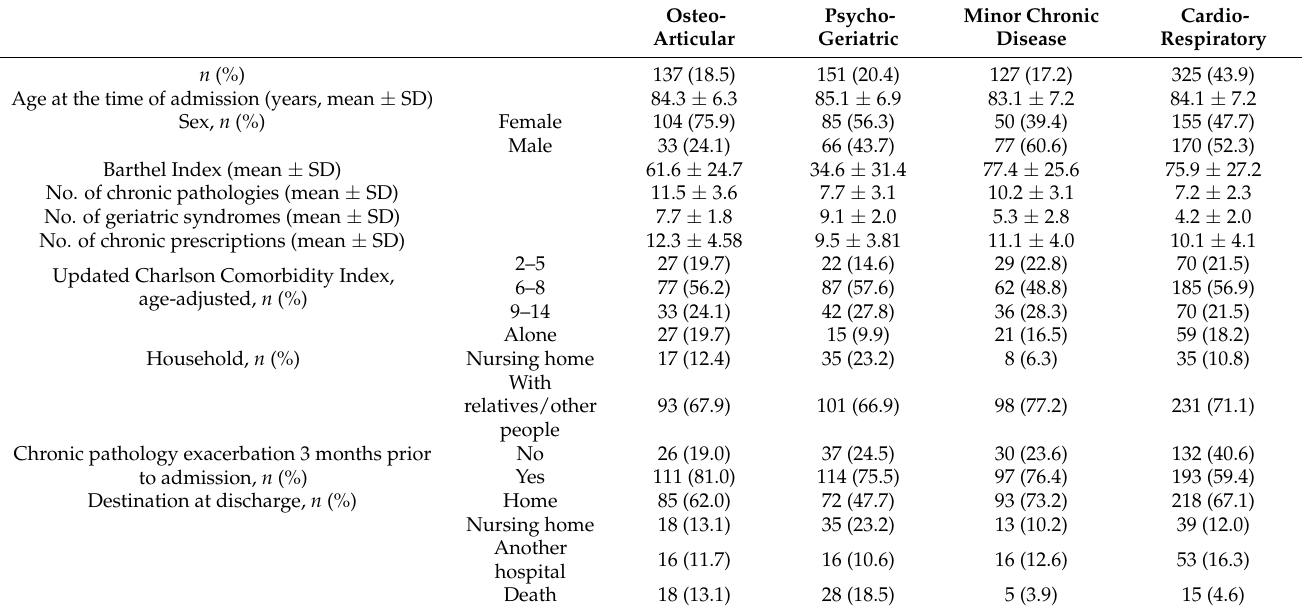
Table 1. Sociodemographic and clinical variables of the cohort according to the assigned multimor- bidity clusters.